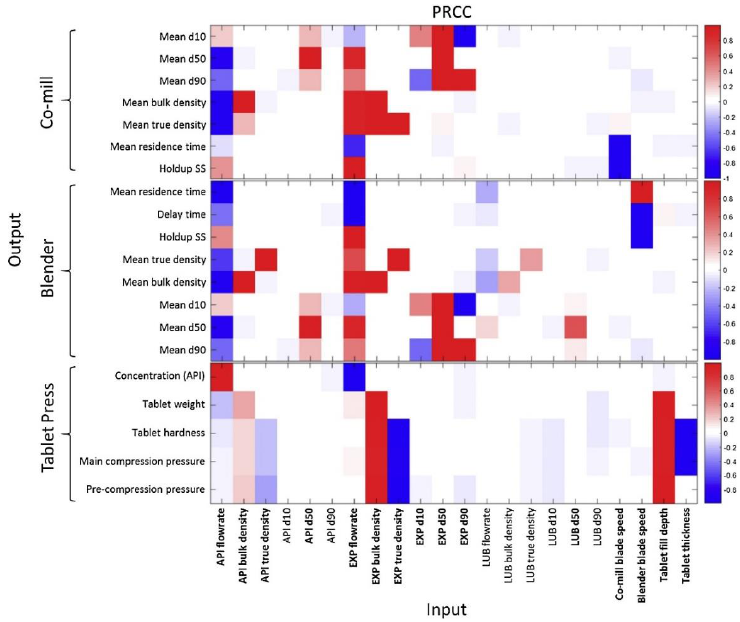
Figure 10. Process sensitivity analysis to aid design space investigation. Reproduced with permission from Wang et al., Computers and Chemical Engineering; published by Elsevier, 2017 [61].